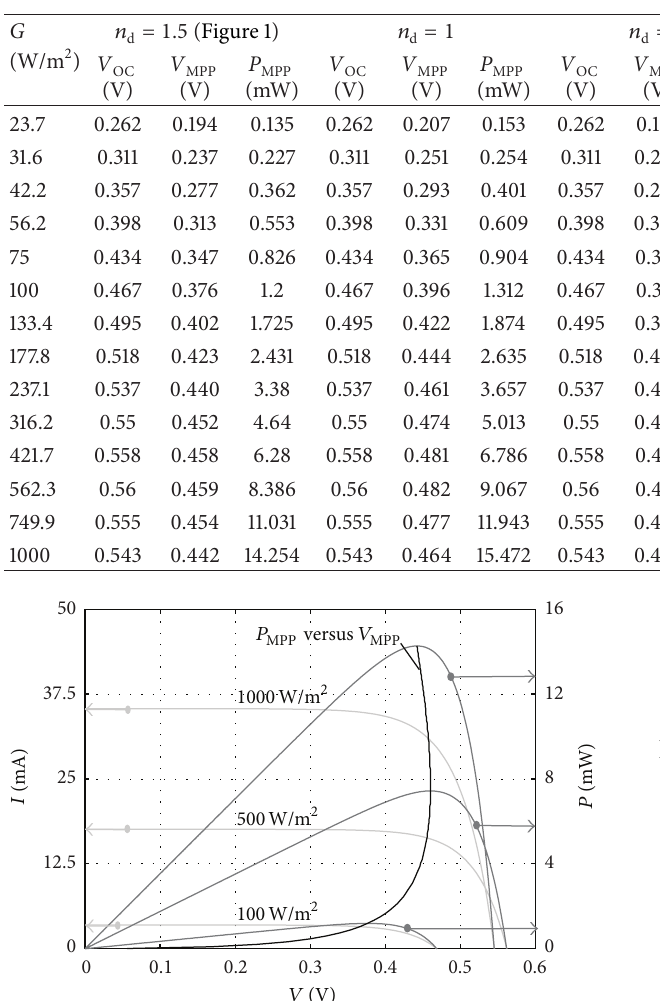
Figure 2: Generic I-V and P-V plots at several values of 𝐺 and at = 25 ∘ Cforasinglesolarcellwithanareaof1 cm 2 .Acurvejoining 𝑇 a the MPPs is also plotted.